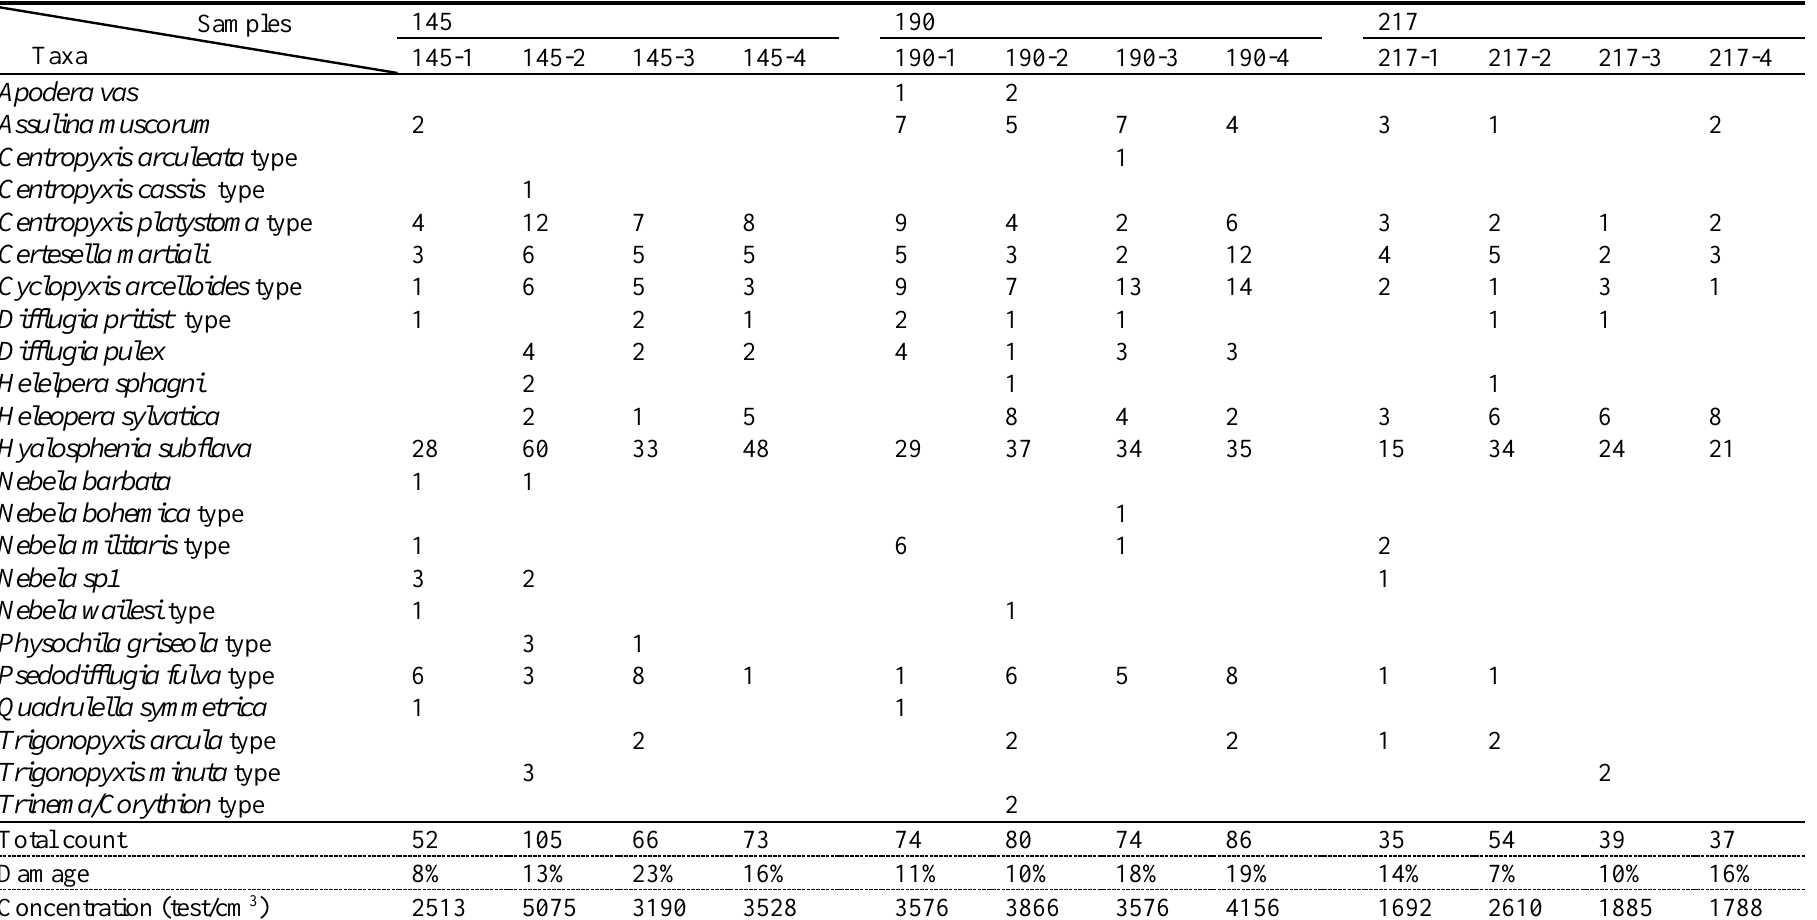
Table 1. Raw counts of testate amoebae in each sample. Samples are grouped according to depth (145, 190 and 217 cm in a core from Snowy Flat bog) and then into the different preparation treatments (1 = water-based preparation; 2 = dispersant; 3 = mild alkaline + acetone; 4 = a combination of dispersant and alkaline + acetone). Damage is the percentage of damaged